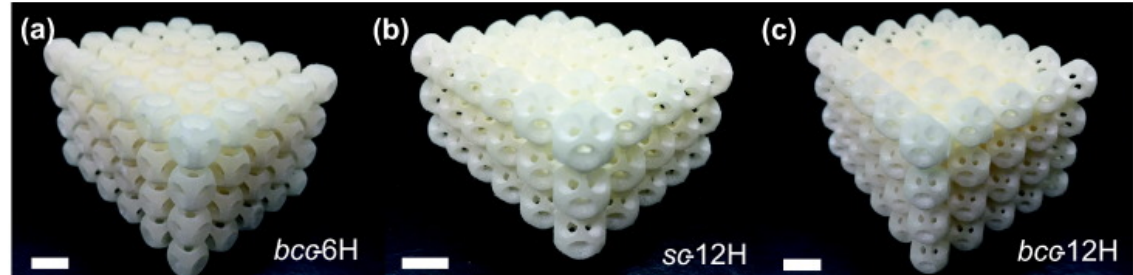
Figure 27. Three distinct printed designs of a 3D soft, auxetic lattice structure, commonly referred to as a Bucklicrystal. These crystal lattices all were SLS-printed using TPU powder and with 60% porosity and show ( a ) a crystal lattice with body-centred-cubic unit-cells with 6 holes, ( b ) a crystal lattice with cubic solid-centred unit-cells with 12 holes, and ( c ) a crystal lattice with body-centred-cubic unit-cells with 12 holes. Here, the scale bar equates to 1 cm [142]. (Reprinted from Materials & Design, Volume 120, S. Yuan, et al., ‘3D soft auxetic lattice structures fabricated by selective laser sintering: TPU powder evaluation and process optimization’, Pages 317-327, Copyright (2017), with permission from Elsevier).